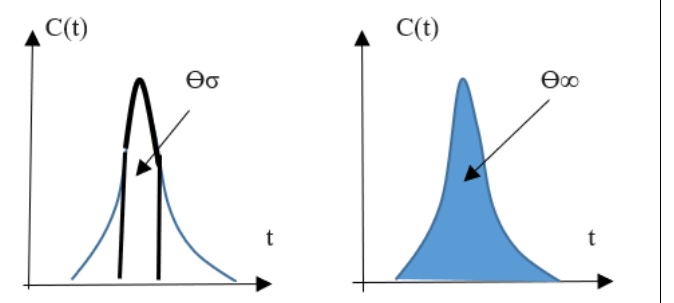
Figure 9: Two residence times of the particle.